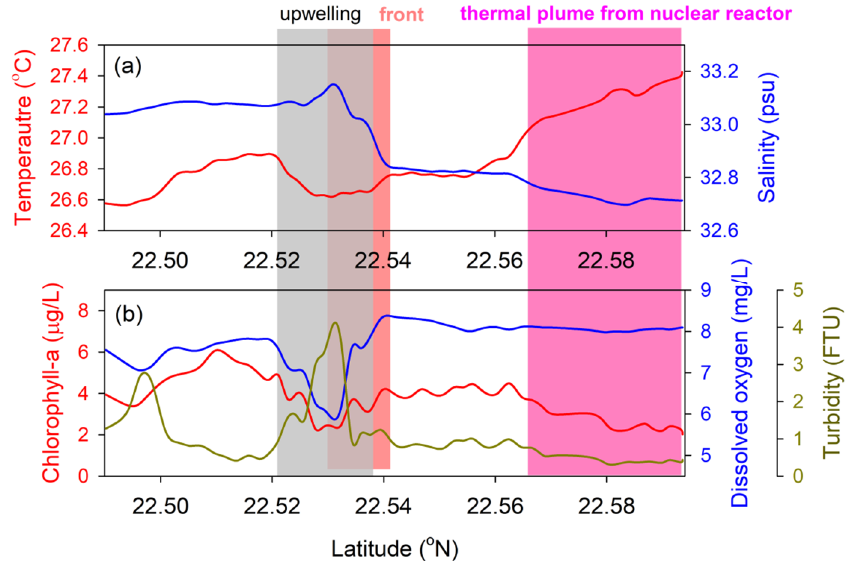
Figure 8. ( a ) Temperature, salinity, ( b ) chlorophyll-a, dissolved oxygen, and turbidity at a depth of 3 m along transect S1. The filled backgrounds indicate the upwelling (gray), front (orange), and warm discharge water from the nuclear reactor